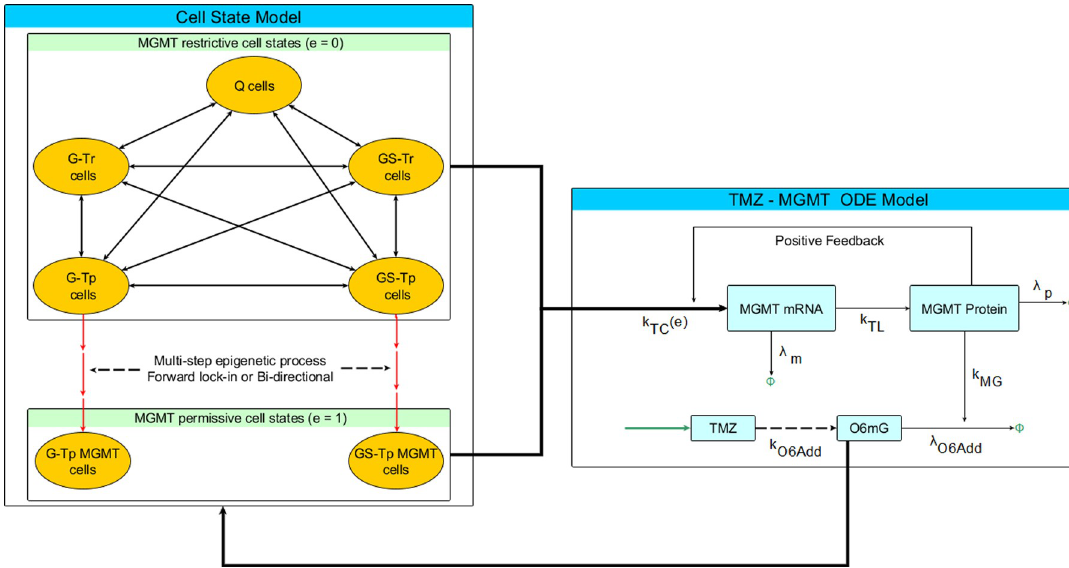
Fig 5. Schematic of the Hybrid Stochastic-Deterministic TMZ-MGMT model. The stochastic cell state model–based on the multi-step model (Fig 3)–is modified to distinguish G-Tp MGMT and GS-Tp MGMT cell populations. The multi-step epigenetic process (either forward lock-in or bi-directional, dotted black line) is specifically used for Tp transitions to Tp MGMT transitions, both G-Tp MGMT and GS-Tp MGMT populations. Both the Tr and Tp cell populations are linked to the MGMT ODE model wherein an epigenetic designation of 0 (restrictive) and 1 (permissive) determines the dynamics of MGMT and O6mG. The TMZ dosing schedule is designated by the green input arrow. TMZ undergoes pH-dependent multi-step metabolic conversion to O6mG adducts (indicated by dotted arrow, see S3 Fig). The quantity of O6mG adducts determines the cell death rate that feeds back to the stochastic cell state model. The rate constants associated with the ODE model are defined in Table B in S1 Text and designated in equations S5-S7.